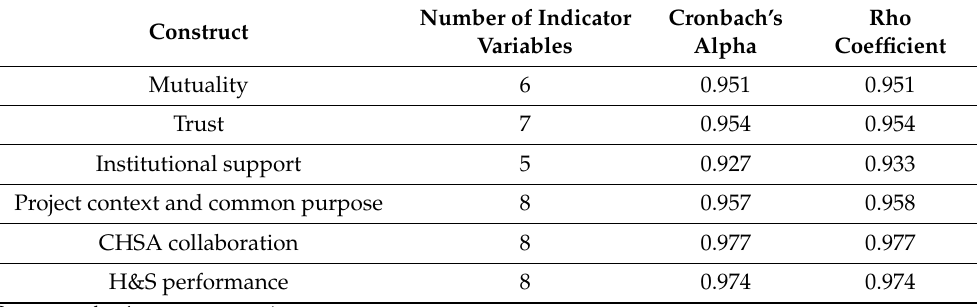
Table 11. Reliability scores for six